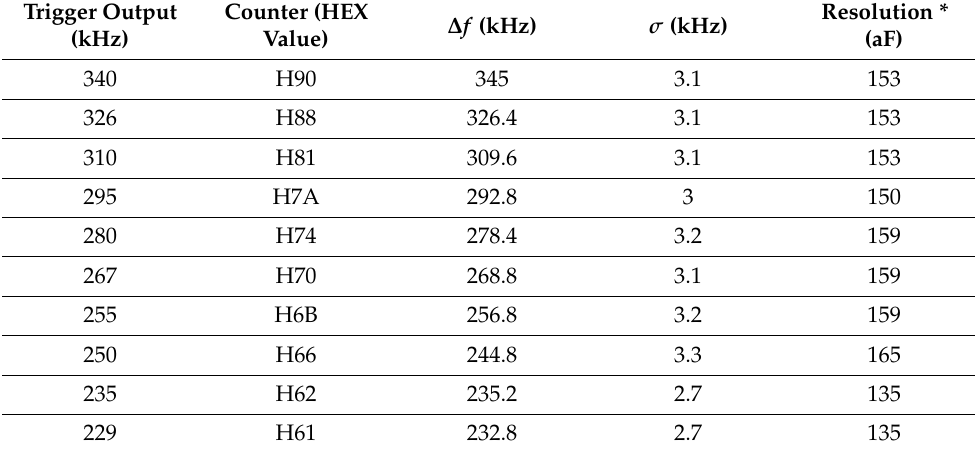
Table 3. Comparison of digital output with measured frequency